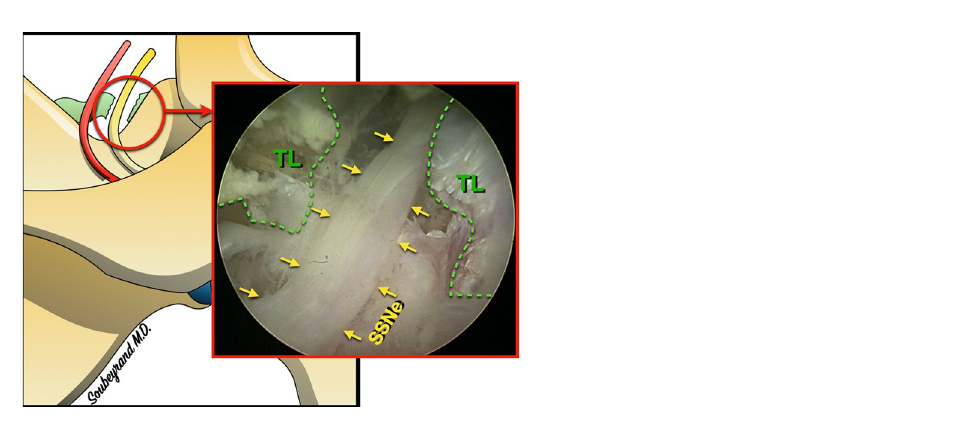
Figure 7. Arthroscopic appearance after section of the superior transverse scapular ligament (TL): the suprascapular nerve (SSNe) appears completely